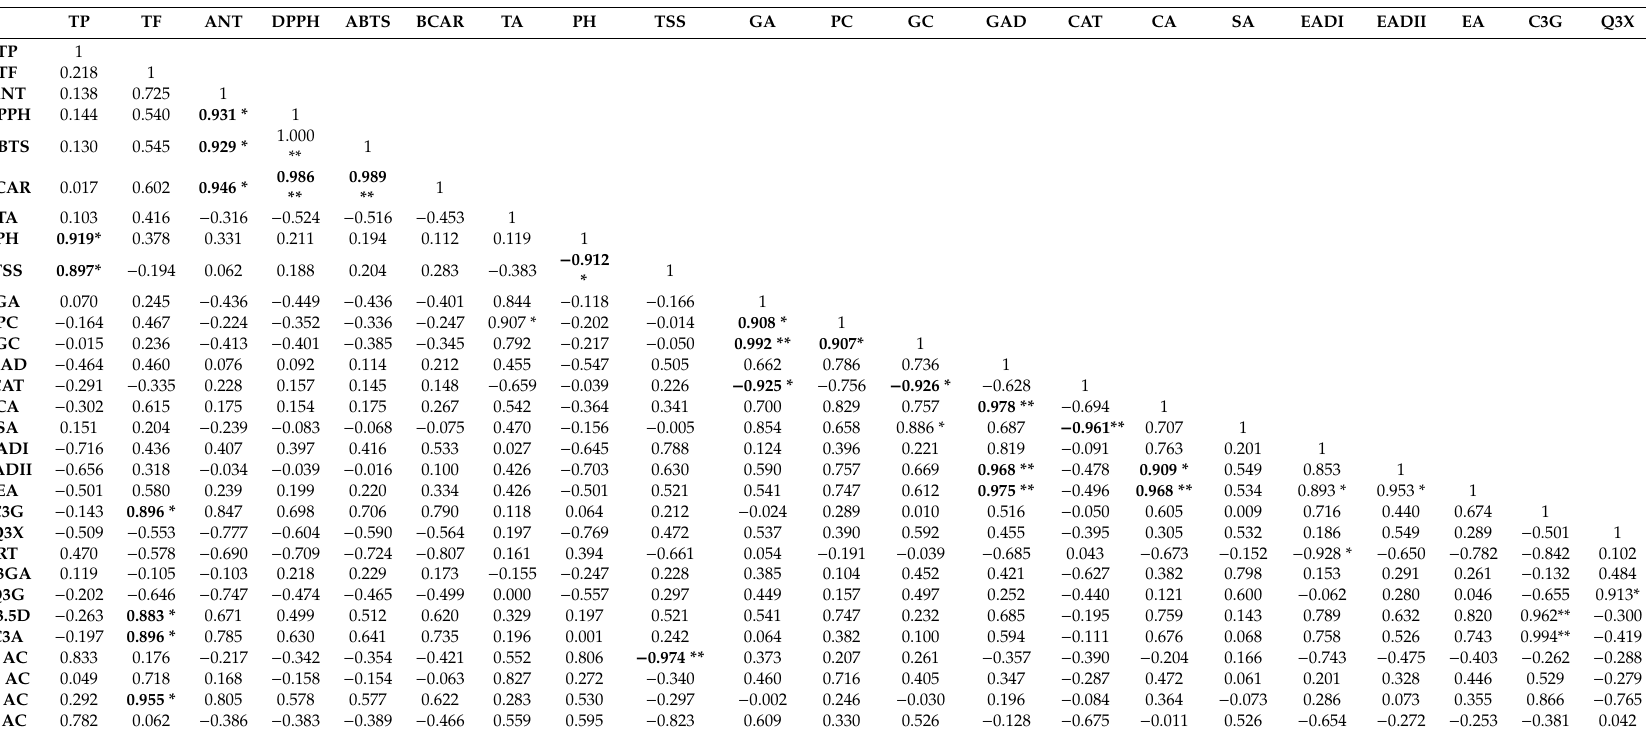
Table 9. Correlation coe ffi cients among biochemical parameters